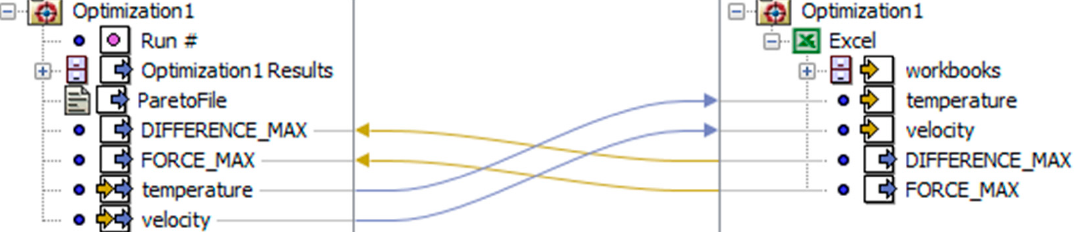
Figure 23. Exemplary view of the connection between particular parameters during optimization using MS Excel and Simulia Isight software.